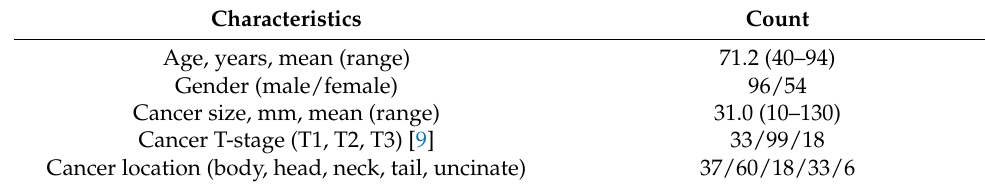
Table 1. Characteristics of the patients and cancer.